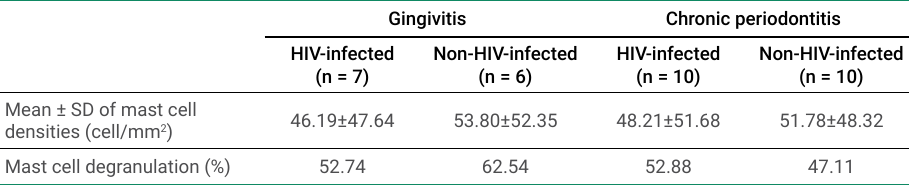
Gingivitis Chronic periodontitis HIV-infected Non-HIV-infected HIV-infected Non-HIV-infected (n = 7) (n = 6) (n = 10) (n = 10)